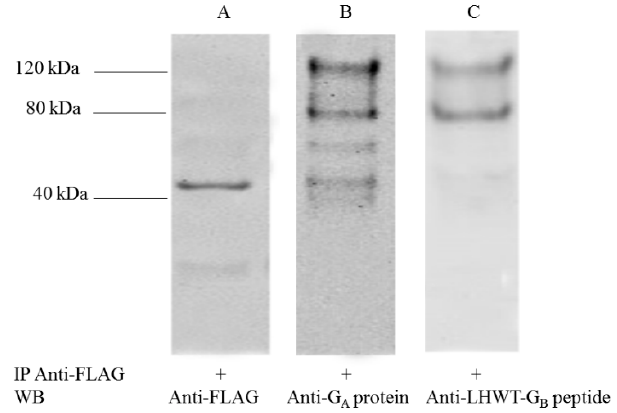
Figure 1. Expression of Ruc-G antigens. Ruc-tagged antigens were immunoprecipitated using beads coated with anti-FLAG IgG and evaluated using Western blot assay as described in materials and methods to confirm expression of Ruc (no insert) (lane A ), Ruc-G A (lane B ), and Ruc-G B (lane C ) antigens in COS-1 lysates using rabbit antisera for detection. Molecular weight markers are noted.